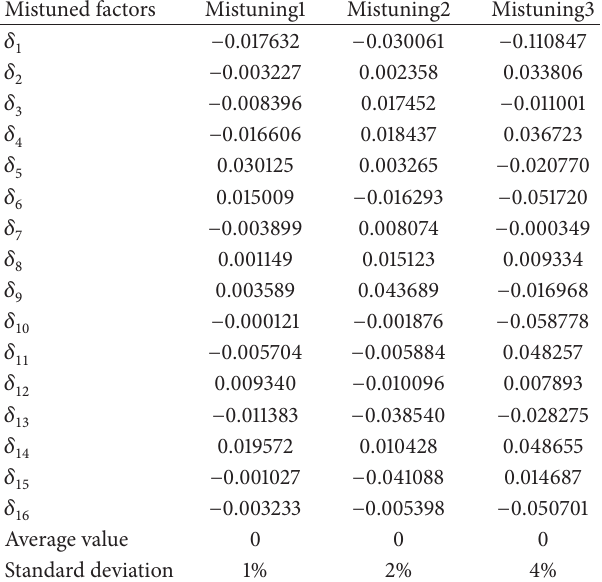
Table 2: Values of mistuned